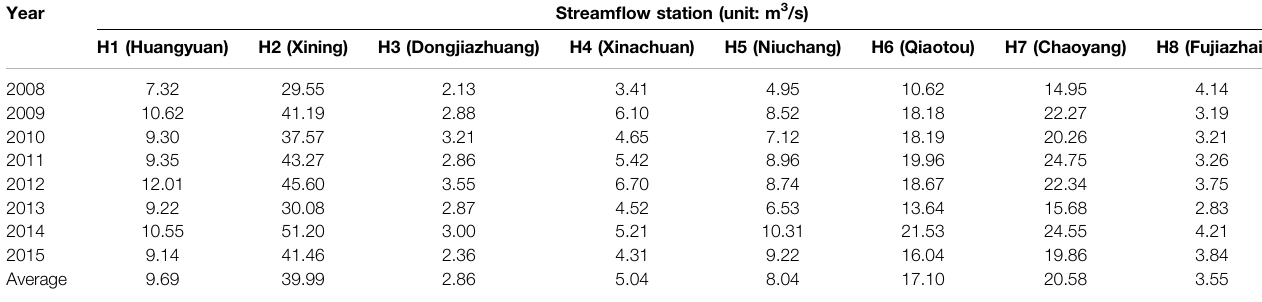
TABLE 1 | Annual average fl ow of each hydrological station. Year Stream fl ow station (unit: m 3